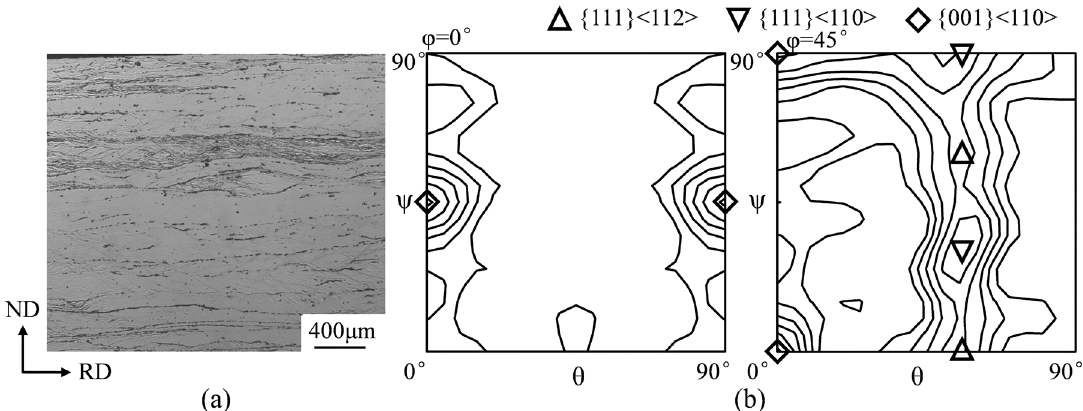
Figure 2. (a) Microstructure and (b) constant φ = 0° and 45° sections of ODFs (levels: 1, 2, 3...) of warm rolled Fe-4.5 wt.% Si sheets under 83% reduction.